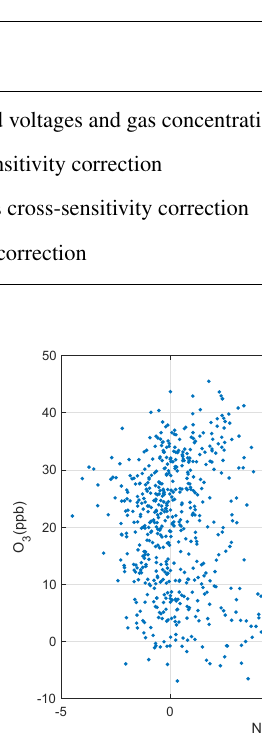
Figure 5. Representative month of 1min averaged NO and O 3 mea- surements taken between 00:00 and 03:00; plumes